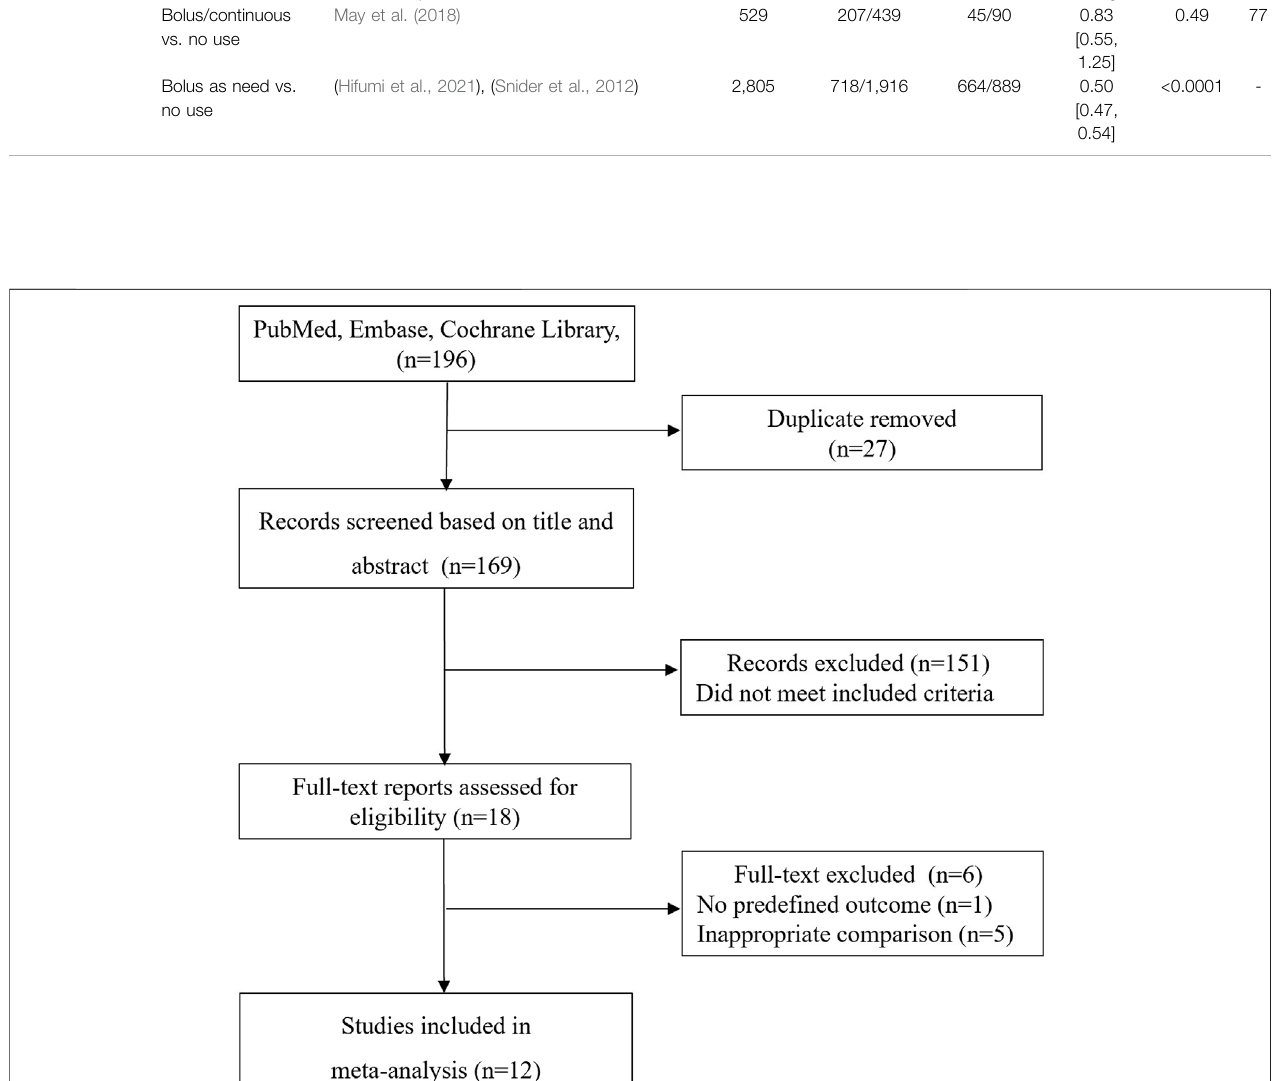
Frontiers in Pharmacology |